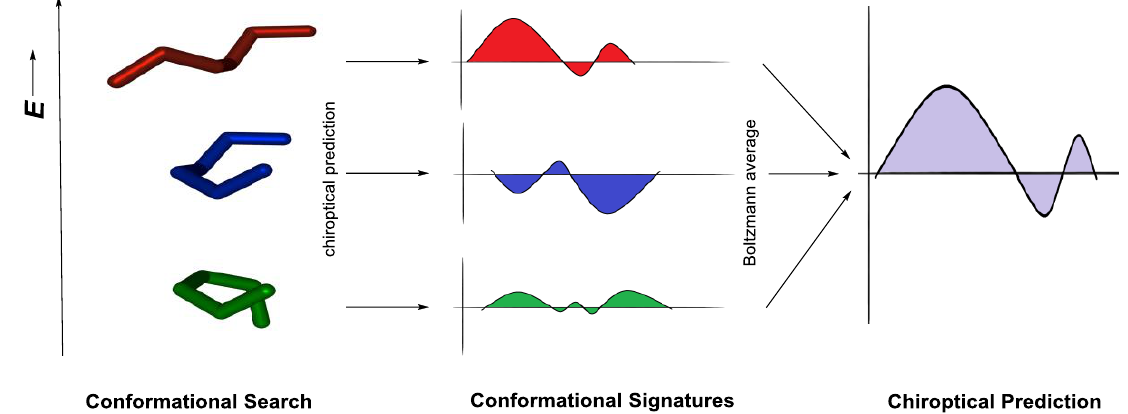
Figure 15. Necessary steps for the chiroptical prediction.